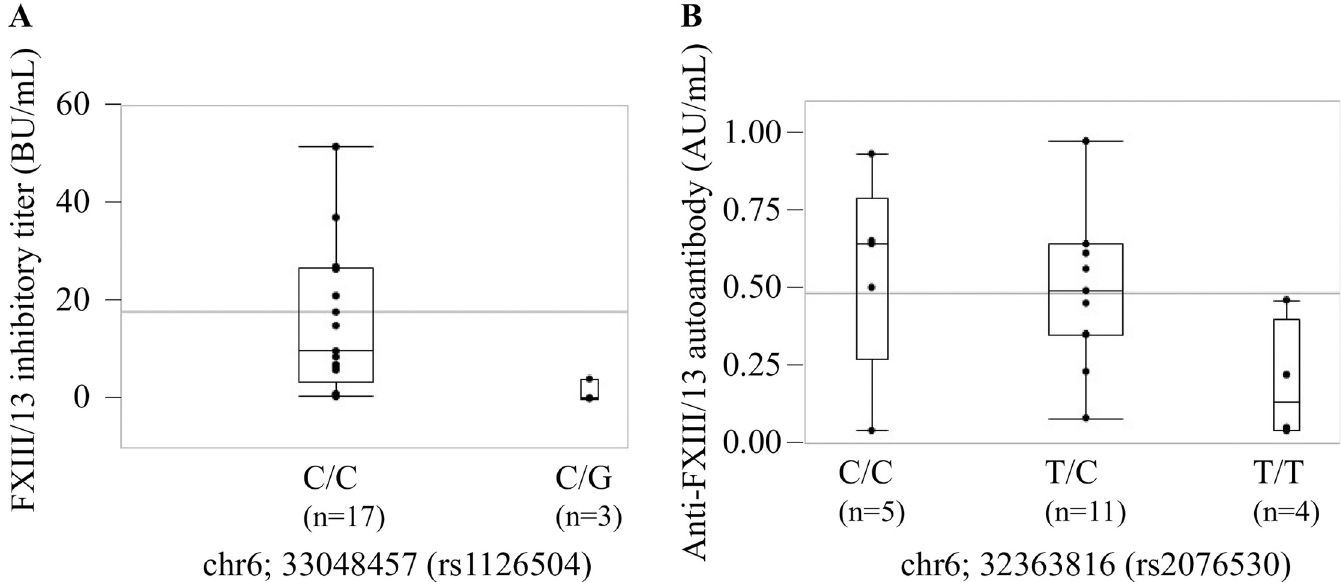
Fig 2. FXIII inhibitory titers and anti-FXIII autoantibody levels in various variants. A , FXIII inhibitory titers (Bethesda unit; BU) in reference allele (C/C) and heterozygous allele (C/G) at chromosome 6; 33048457 in HLA-DPB1 (rs1126504). B , Anti-FXIII autoantibody levels measured using ICT (arbitrary unit; AU) as described in “ Materials and Methods ” in reference allele (T/T), heterozygous allele (T/C) and homozygous allele (C/C) at chromosome 6; 32363816 in BTNL2 (rs2076530).